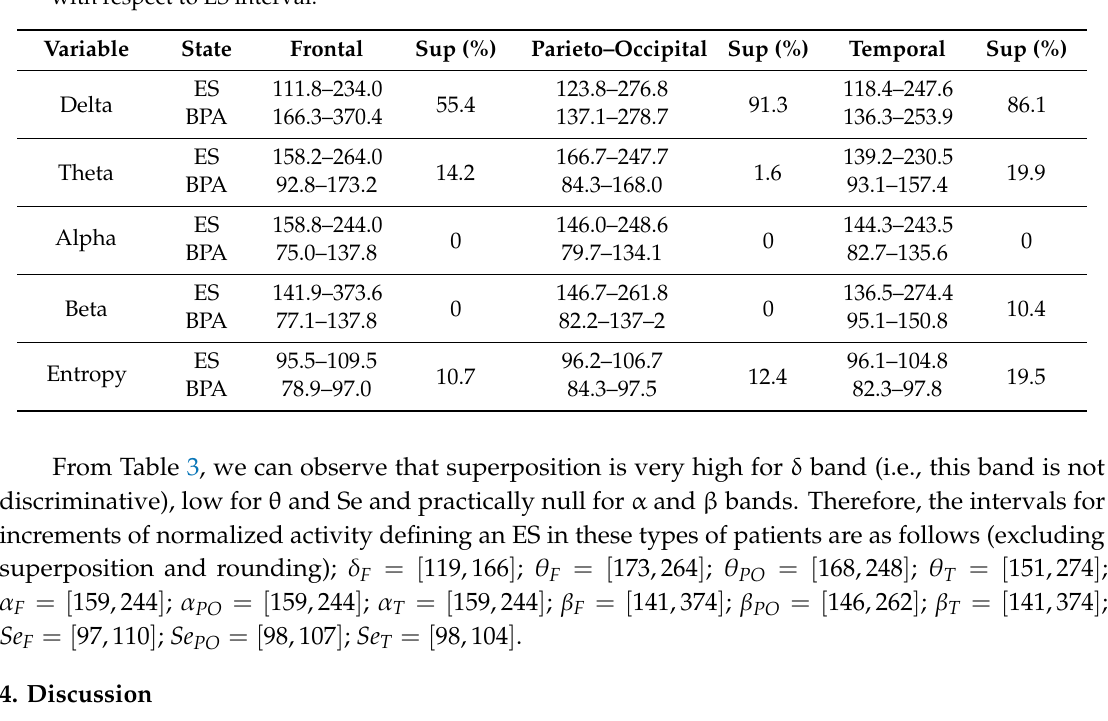
Table 3. Inter-percentile 25–75 intervals for bands and lobes in BPA and ES. Superposition is indicated with respect to ES